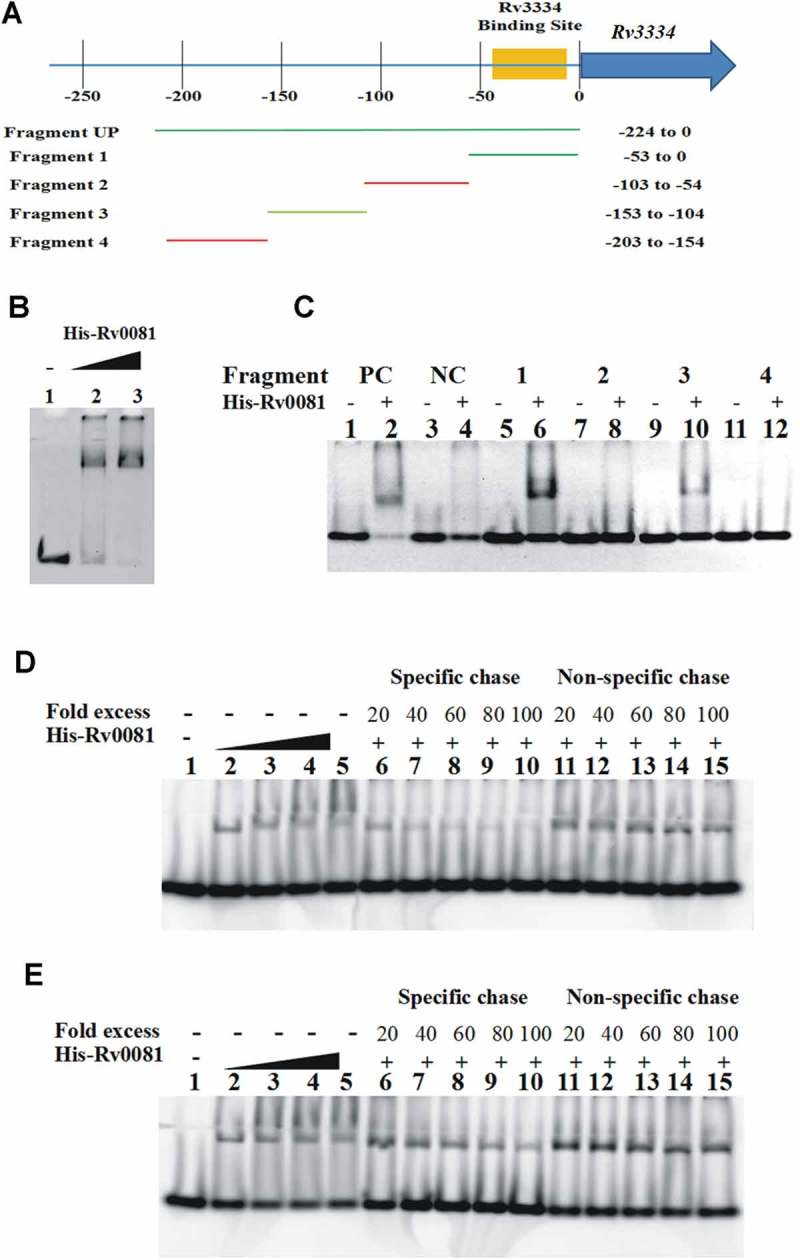
Rv0081 binds the promoter of Rv3334. (a) Schematic representation of different fragments upstream of Rv3334 that were used in EMSAs to identify the binding site of Rv0081. DNA fragments are labeled as Fragment 1 to 4 and Fragment UP. Their corresponding positions with respect to start codon are indicated. The region marked by yellow shadow represents the 22-bp palindromic sequence, which is the binding site of Rv3334. (b) EMSA with Fragment UP. Lane 1: no protein; lane 2: 288 ng Rv0081 protein; lane 3: 576 ng Rv0081 protein. (c) EMSA with Fragment 1 to 4. For all reactions, 576 ng purified Rv0081 was used. Presence and absence of protein are indicated by (+) and (−), respectively. Lanes 1 & 2: positive control; lanes 3 & 4: negative control; lanes 5 & 6: Fragment 1; lanes 7 & 8: Fragment 2; lanes 9 & 10: Fragment 3; lanes 11 & 12: Fragment 4. (d & e) FAM-labeled Fragment 1 (d) and Fragment 3 (e) (10 pmol each) were applied in chasing system and visualized by fluorescence radiation. Lane 1: no Rv0081 protein; lanes 2 to 5: Rv0081 protein at 288-, 576-, 864- and 1152-ng were added; lanes 6 to 10: Rv0081 (1152 ng) and excessive unlabeled specific DNA were added; lanes 11 to 15, Rv0081 (1152 ng) and excessive unlabeled nonspecific DNA were added. PC: positive control, a 59-bp DNA fragment from the upstream region of Rv0081. NC: negative control, a 40-bp fragment from the upstream of hycD.